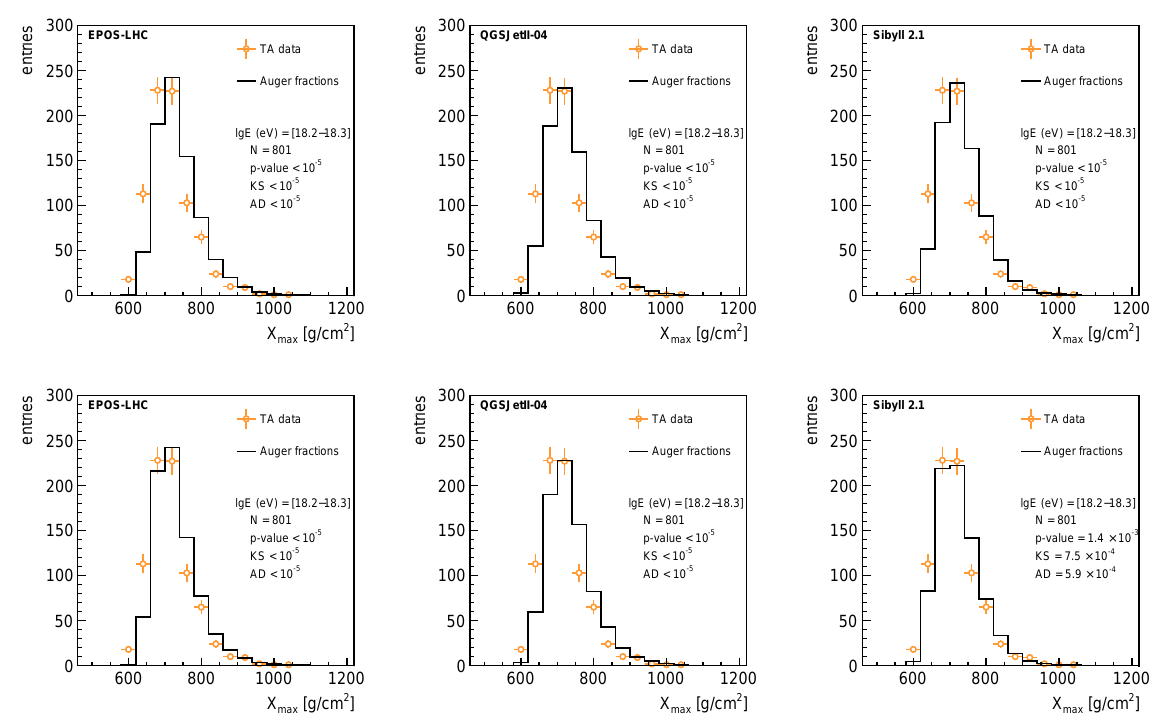
→ TA max in the energy interval lg E (eV) = [18.2–18.3]